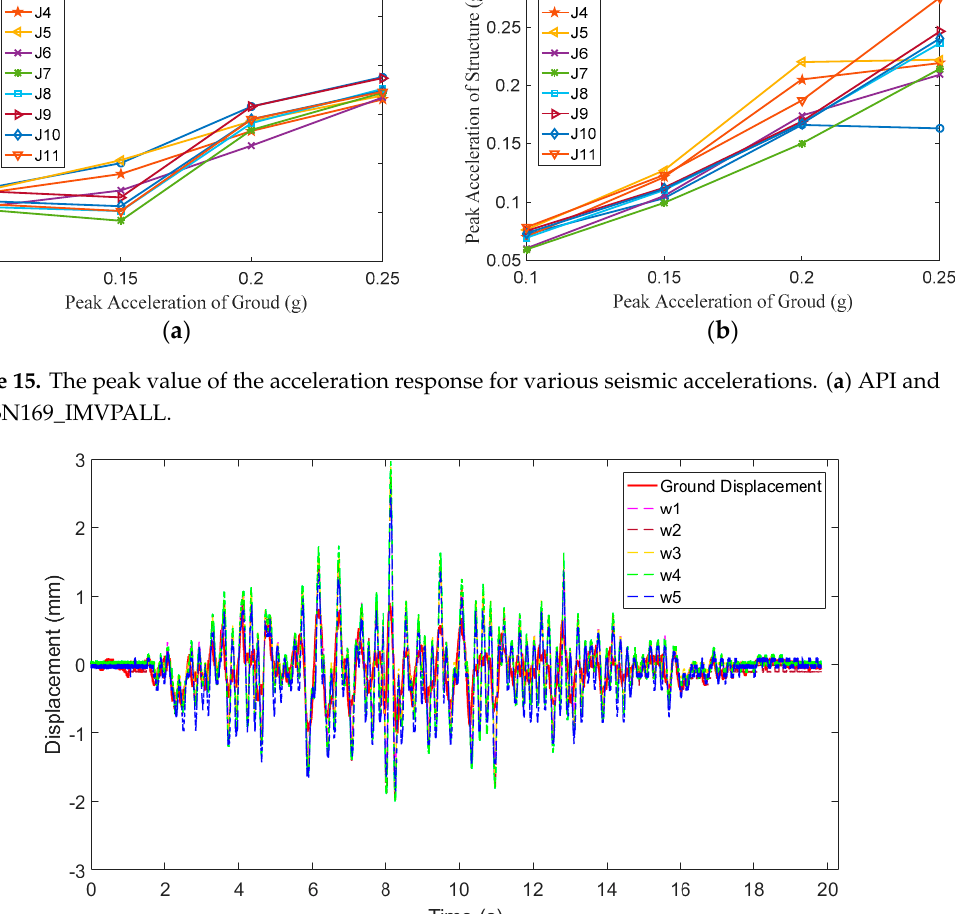
Figure 16. Time series of displacement response under the API seismic wave with a peak ground acceleration of 0.25